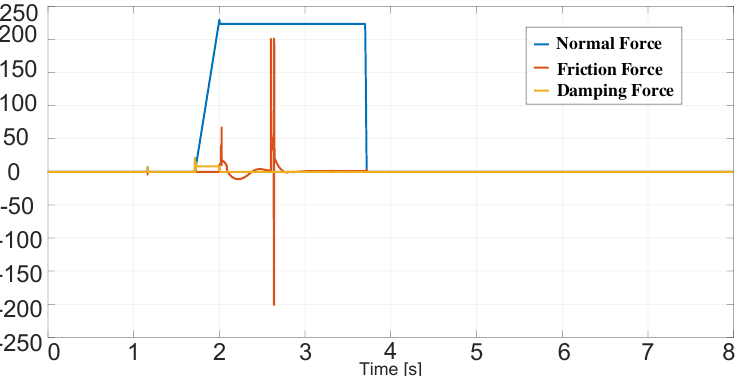
Figure 11. Contact forces between the first finger and the first dumbbell.